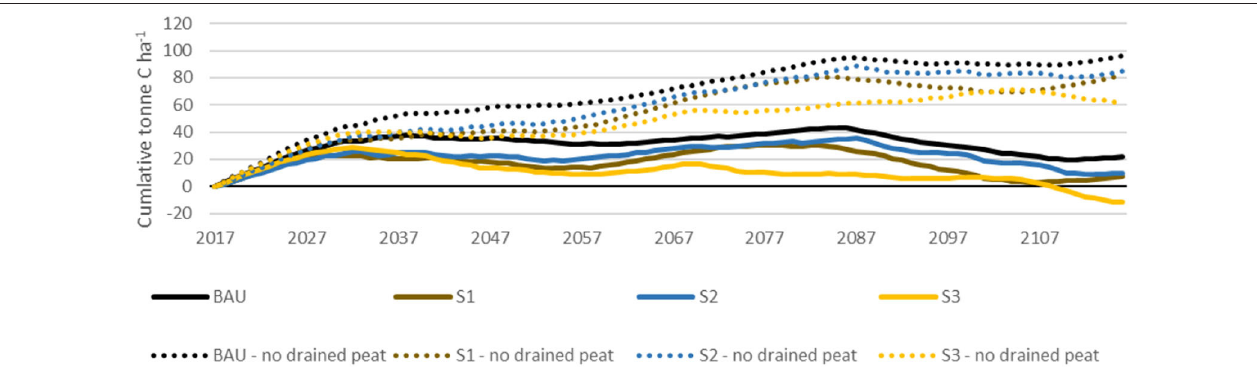
FIGURE 4 | Cumulative stored carbon by year, in tons ha − 1 , for the four scenarios (solid lines), as well as for the four scenarios when emissions from drained peat soils are excluded (dashed lines).